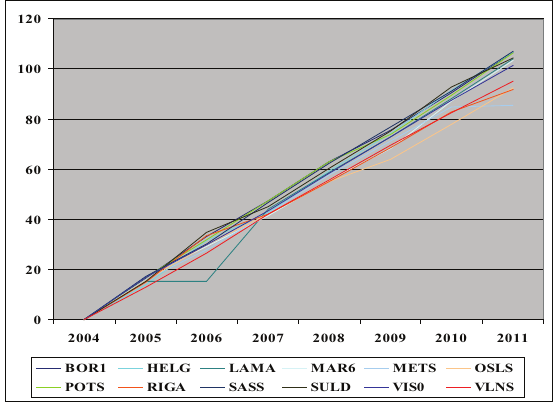
Fig. 5. The displacements of coordinate Y of the stations (mm)